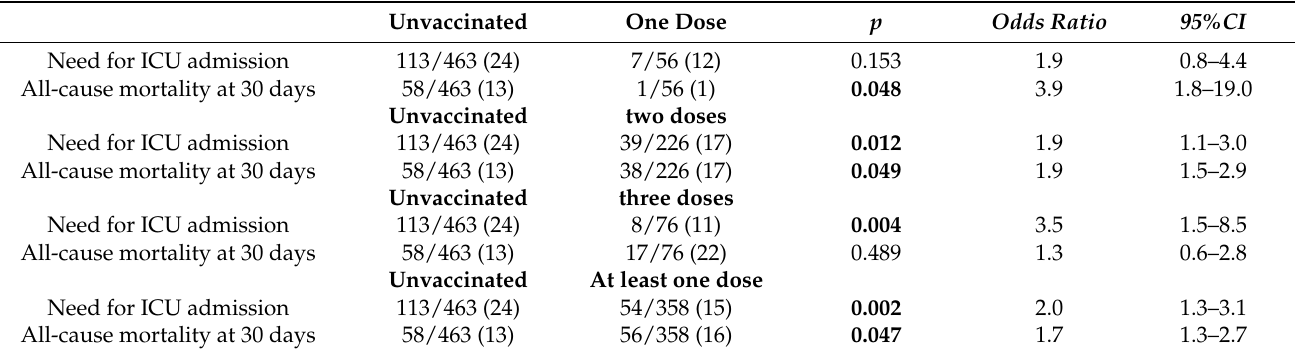
Table 4. Multiple logistic regression analysis to evaluate differences in outcomes (need for ICU and death at 30 days) on the bases of vaccine status (no vaccination, one dose, two doses, three doses, at least one dose) after correction for age, sex, comorbidities, use of anticoagulants, and treatment. (Significant p values are in bold).